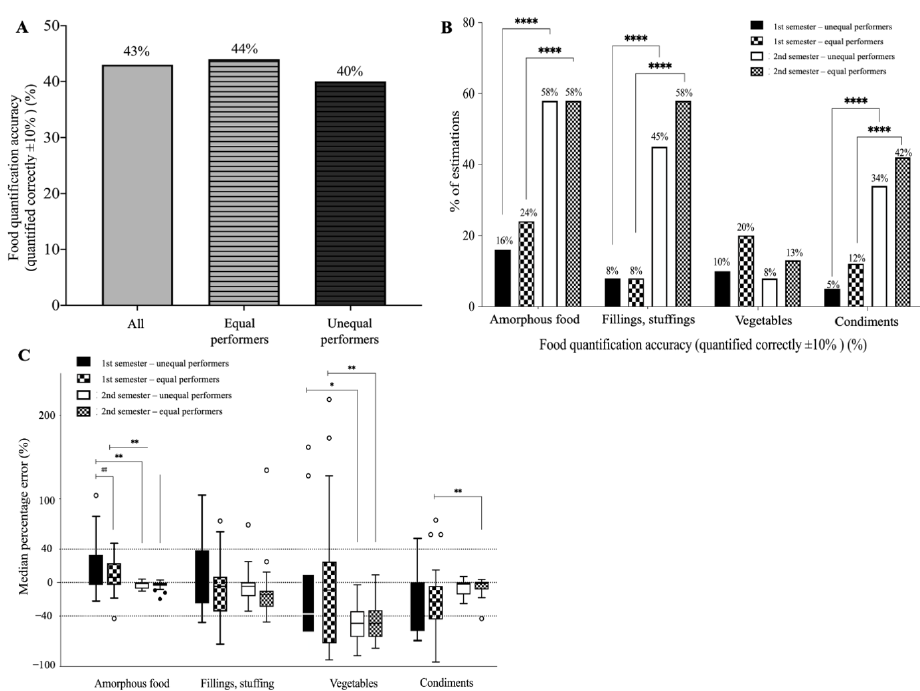
Figure 4. Overall food quantification accuracy (within ±10% difference of total calories) ( A ), estimation accuracy stratified by food groups ( B ), and median percentage error ( C ) of estimated calories in the second semester ( n = 65). Equal and unequal performers were defined as a performance difference between 2-D and 3-D estimates of <6 or ≥ 6 out of 12 tested food items, respectively, in the first semester. ## p < 0.01 for comparing two groups of students; * p < 0.05; ** p < 0.01; **** p < 0.0001 for difference within groups over time .